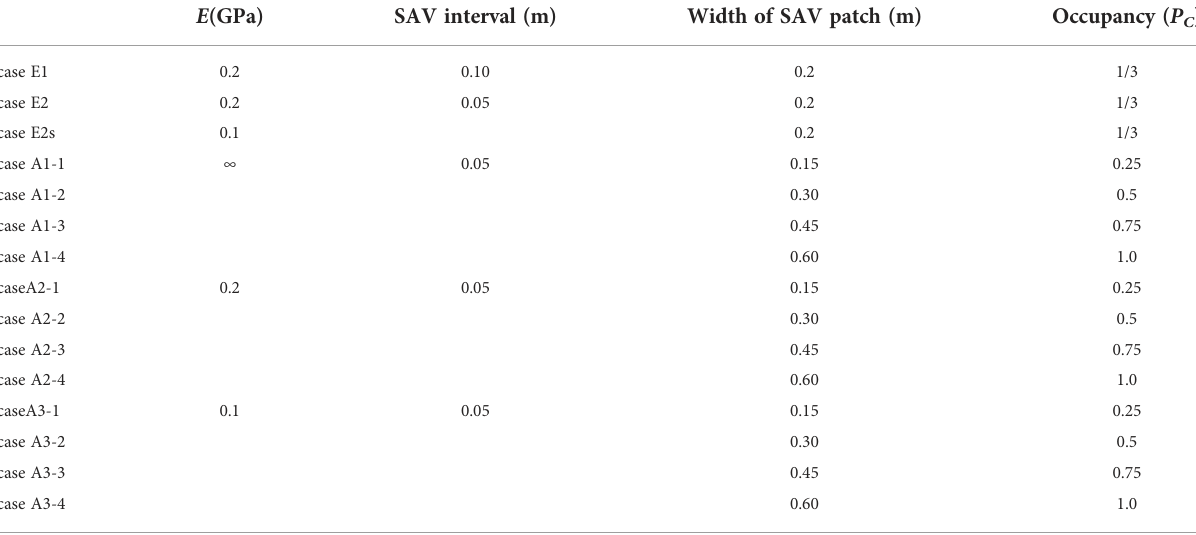
TABLE 1 Conditions for laboratory experiments and numerical